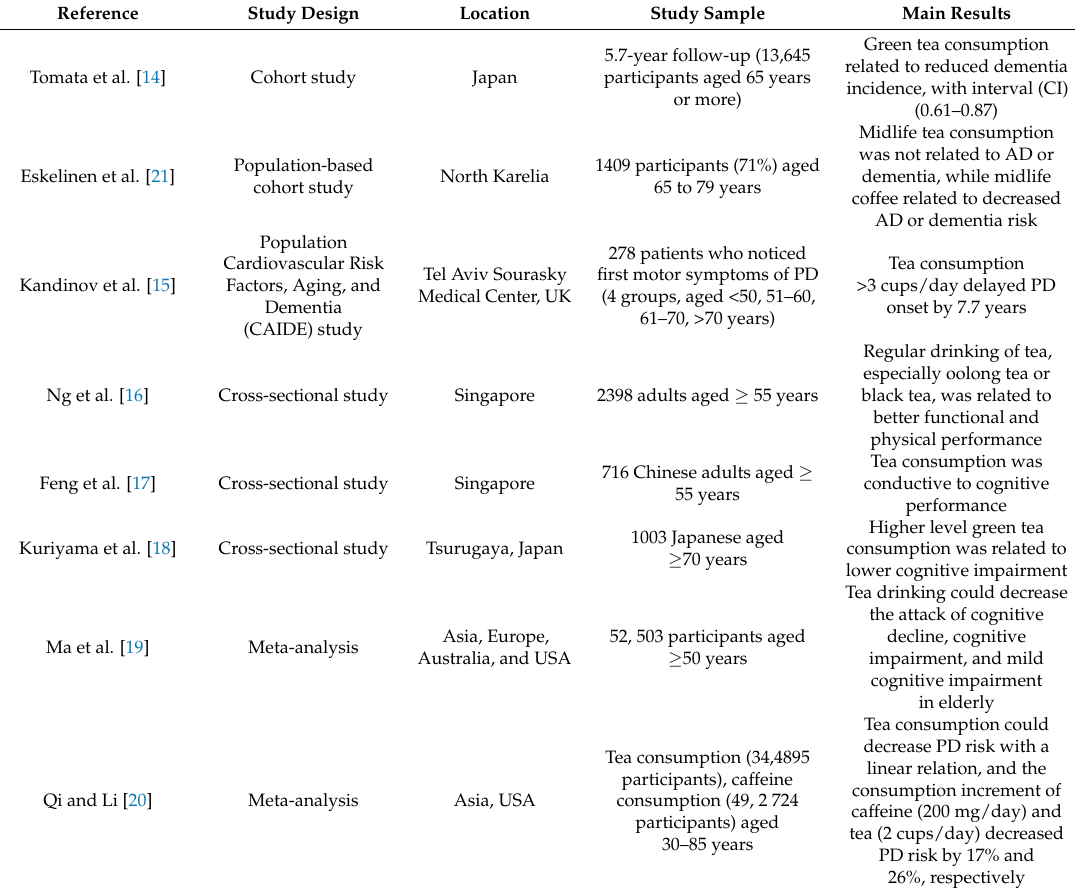
Table 1. Epidemiologic studies for tea consumption effects to neuro